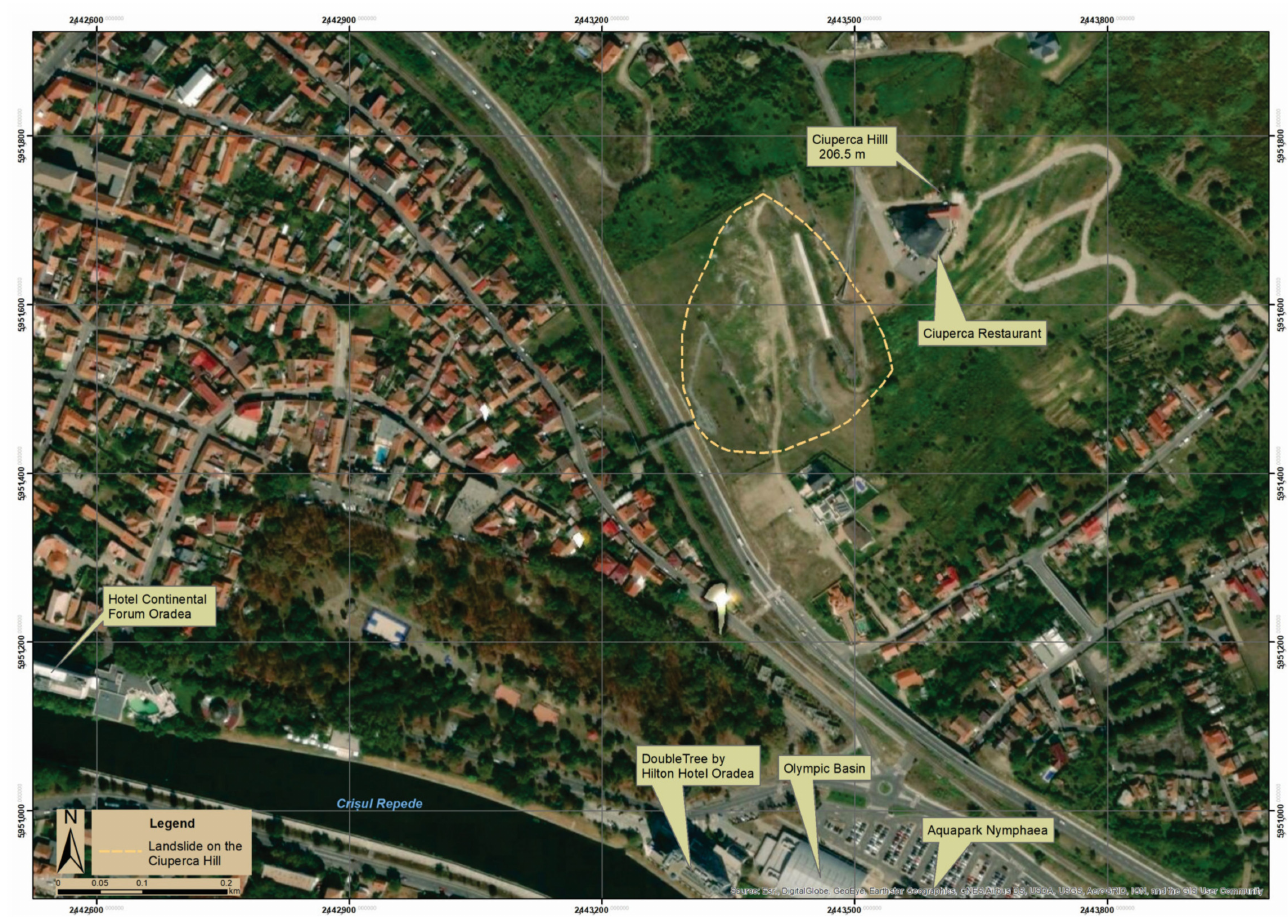
Figure 3. The Ciuperca Hill–Cris